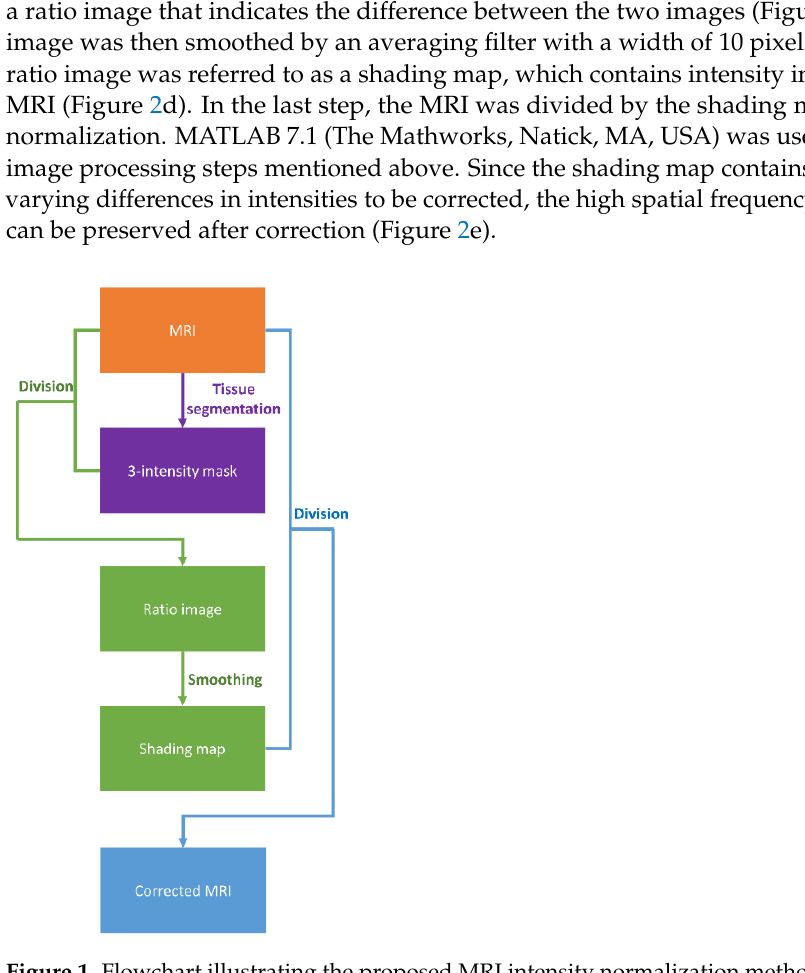
Figure 1. Flowchart illustrating the proposed MRI intensity normalization method.